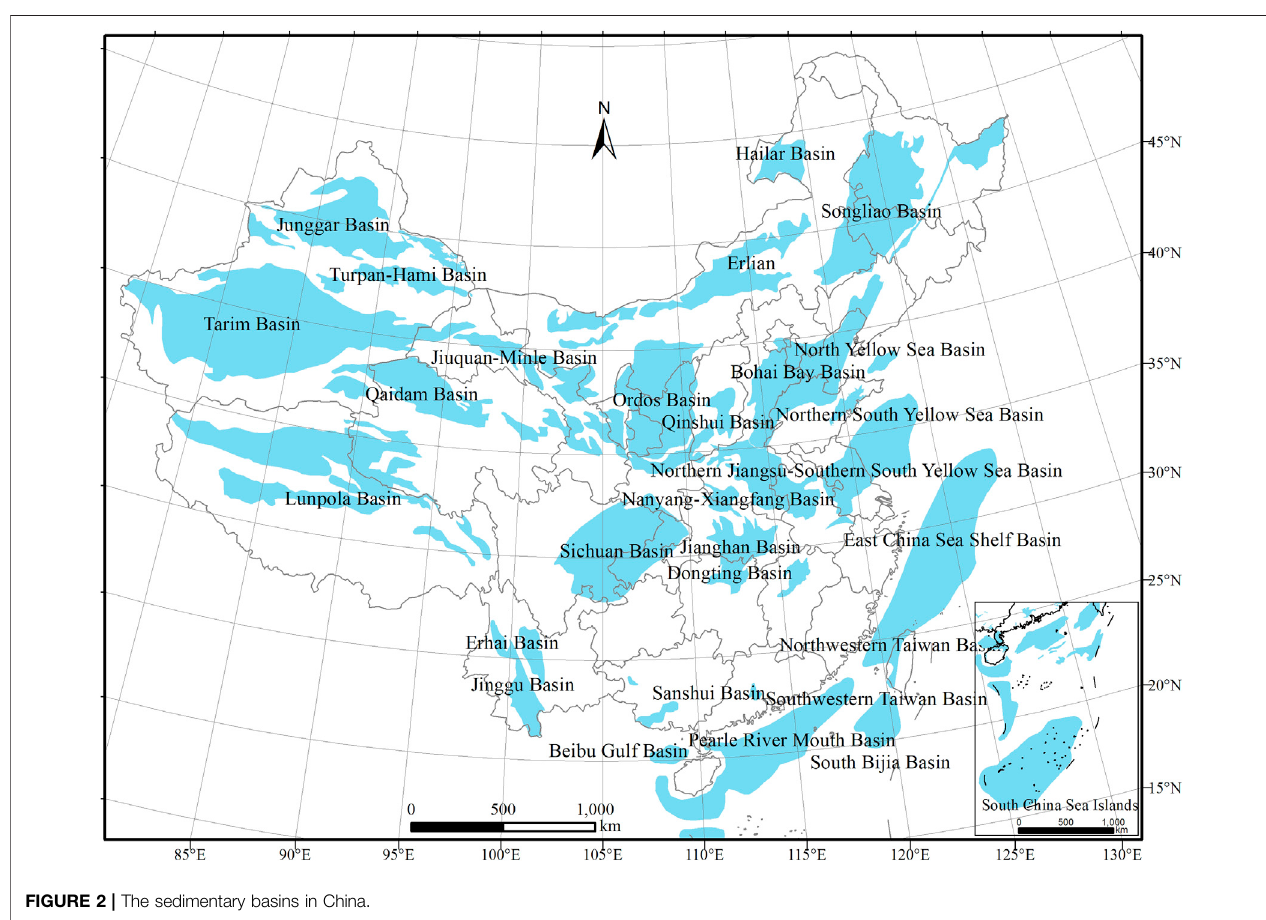
FIGURE 2 | The sedimentary basins in China.